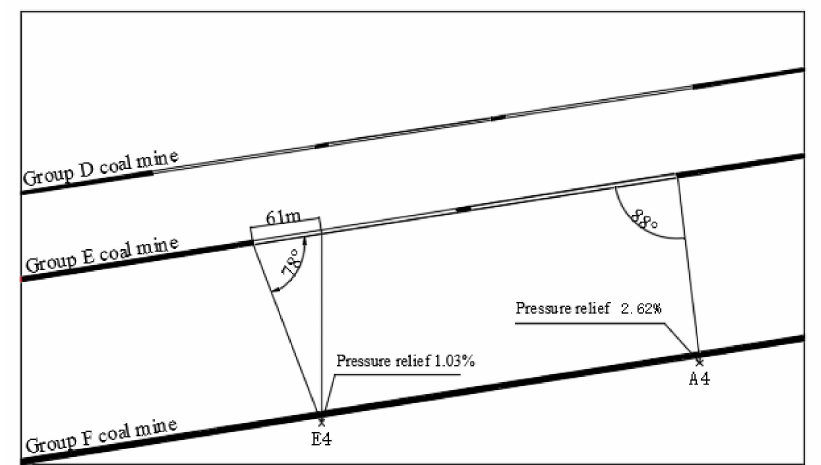
Figure 14. Pressure-relief range of Group F coal